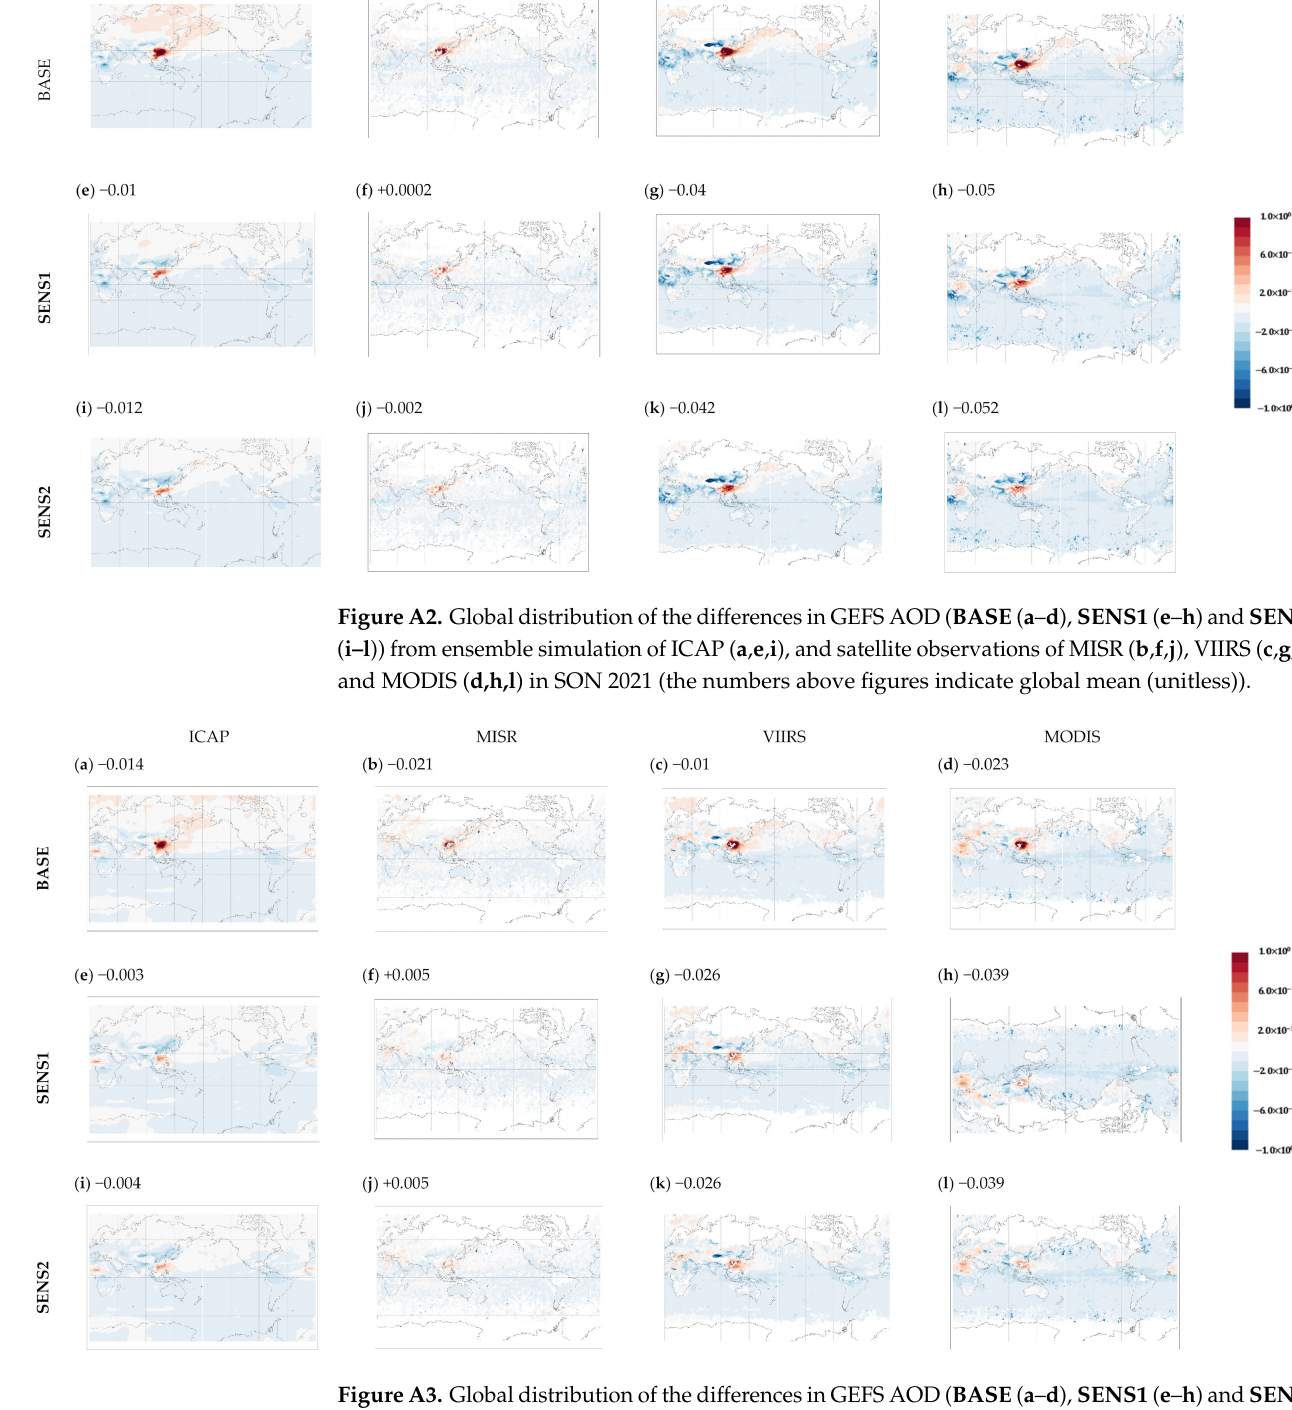
Figure A3. Global distribution of the differences in GEFS AOD ( BASE ( a – d ), SENS1 ( e – h ) and SENS2 ( i–l )) from ensemble simulation of ICAP ( a , e , i ), and satellite observations of MISR ( b , f , j ), VIIRS ( c , g , k ), and MODIS ( d , h,l ) in DJF 2021 (the numbers above figures indicate global mean